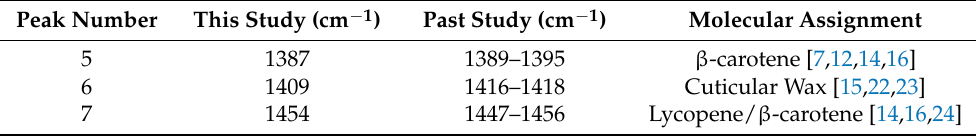
Table 2. Molecular assignment for each peak for Area 2.